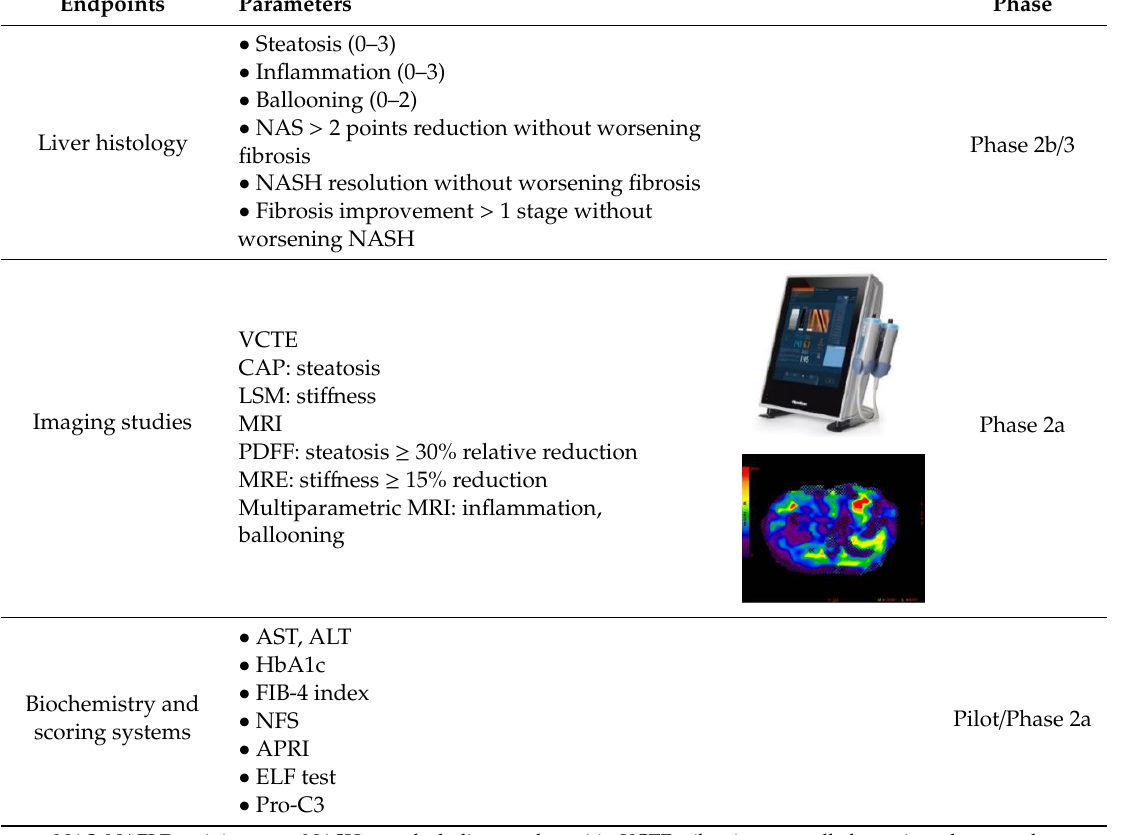
Table 4. A variety of endpoints of antidiabetic agents for NASH according to study design (phase 2/3). Endpoints Parameters